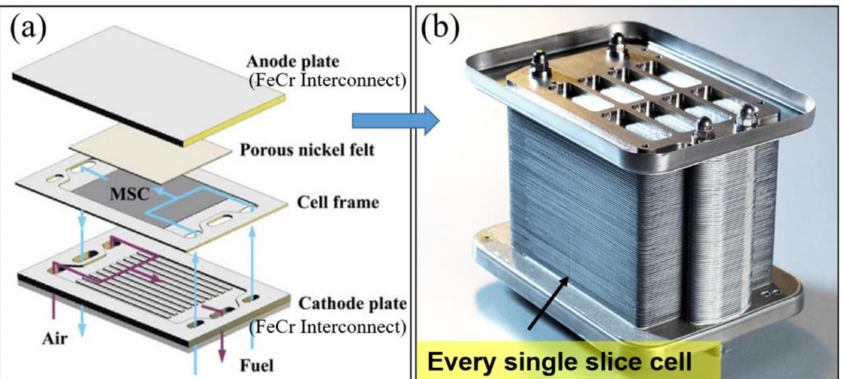
Figure 3. ( a ) Diagram of MSCs stack’s structure, reproduced with permission from Ref. [35]; ( b ) 1 kW MSCs stack manufactured by Ceres Power, reproduced with permission from Ref.